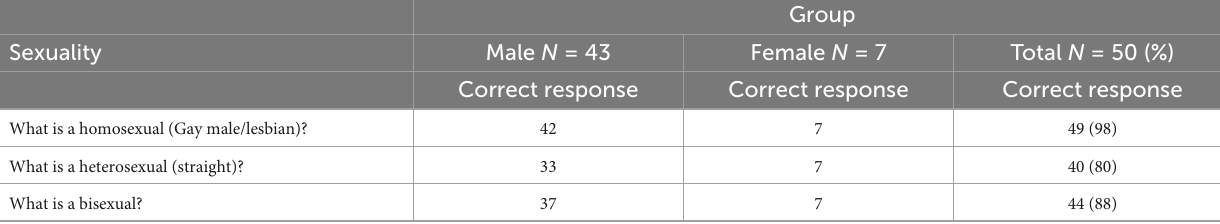
TABLE 11 Means and standard deviations of the respondent’s scores on the General Sexual Knowledge Questionnaire (GSKQ) for both males and females.